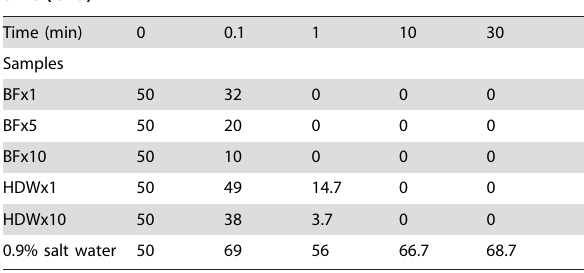
Table 4. Bacterial killing kinetics of cathelicidin-BF and HDW against E. coli